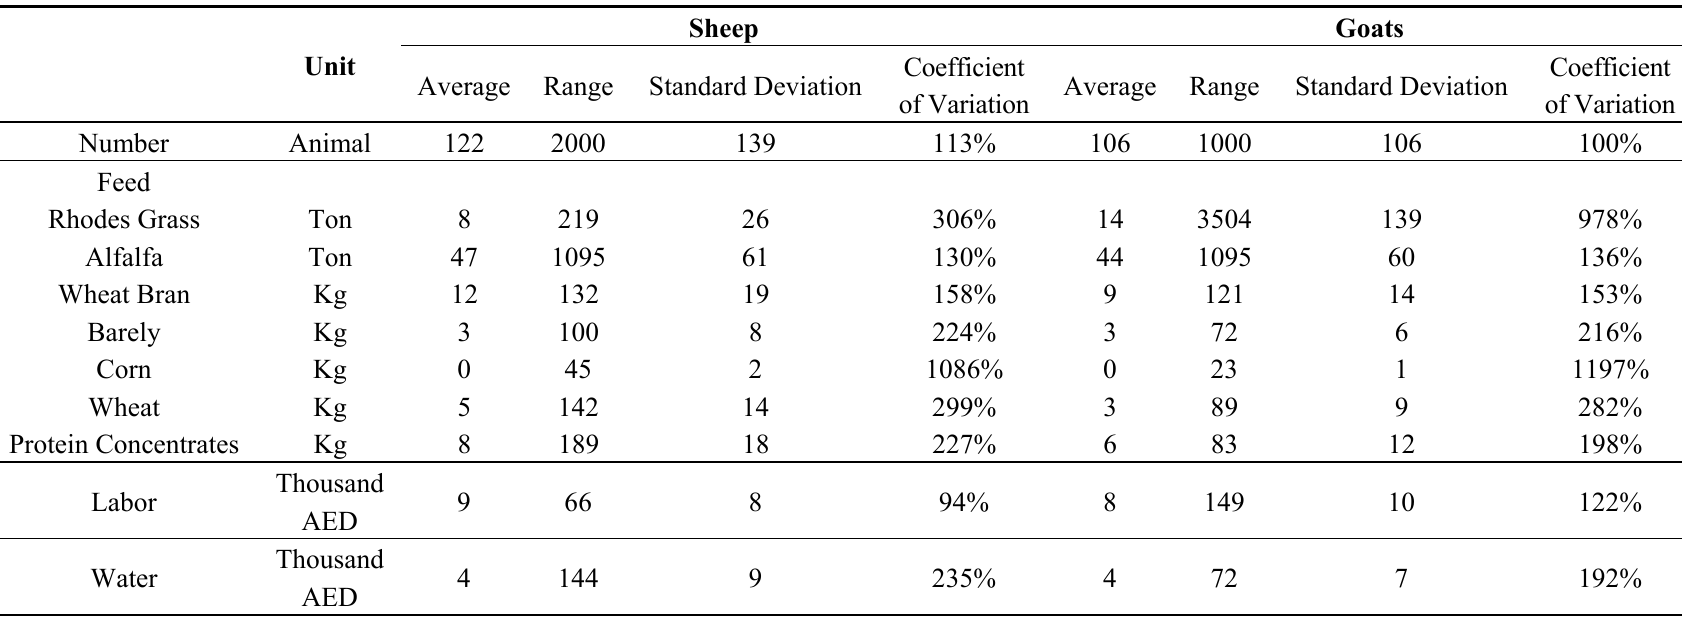
Table 1. Descriptive statistics of output and input variables for sheep and goat production in Abu-Dhabi Emirate. AED, Arab Emirates